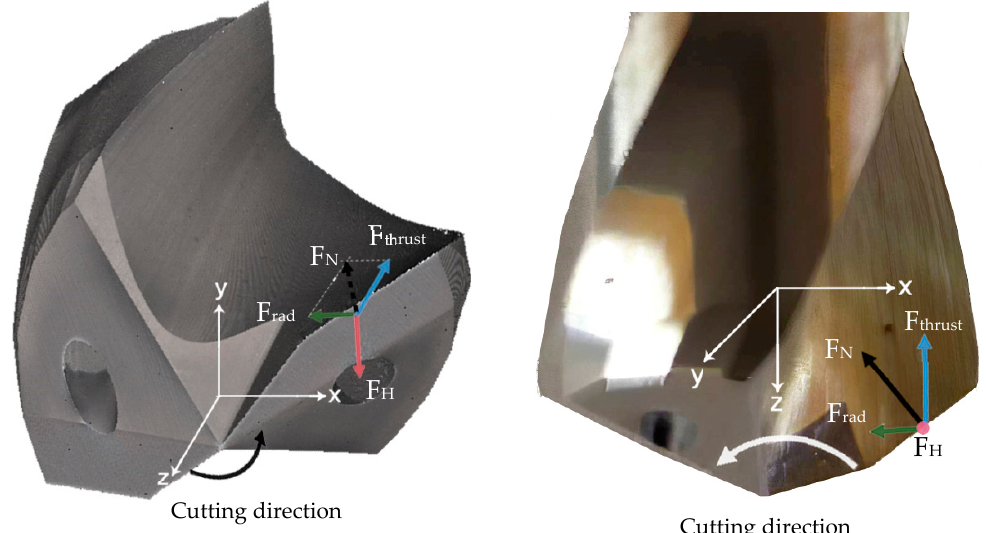
Figure 3. The forces exerted on a main cutting lip of the drill bit.